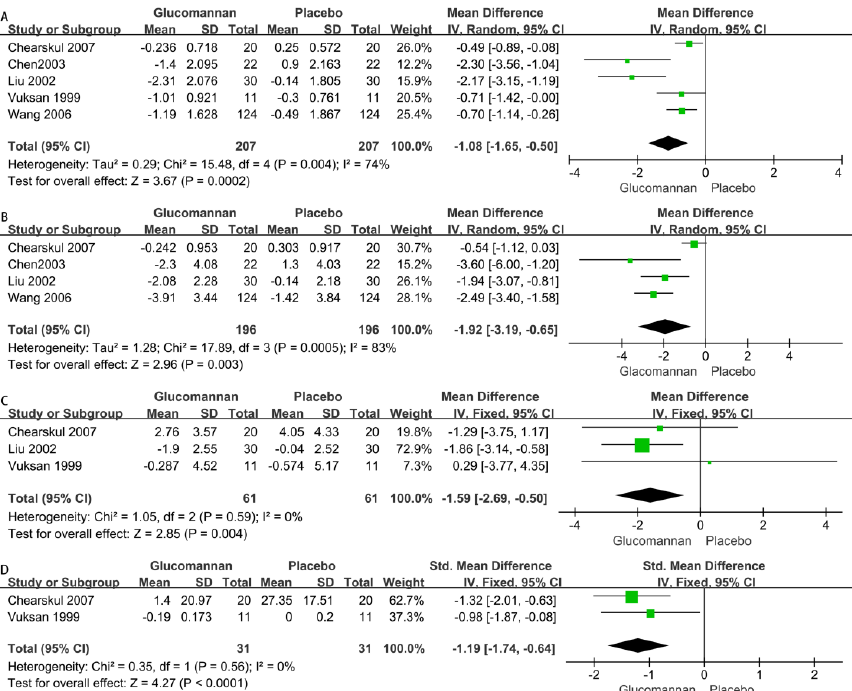
Figure 5. Forest plot of studies [20 – 23,25] on the effect of glucomannan intake on glycemic indices included in this analysis. Effects of glucomannan on FBG ( A ), P2hBG ( B ), FINS ( C ), and SFRA ( D ), where green boxes indicate the odds ratio of the original research data and black diamonds indicate the overall odds ratio of studies included.